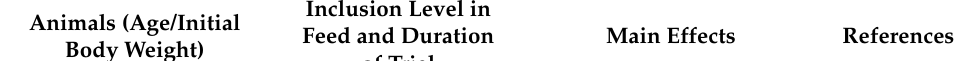
Table 5. Summary of the main effects of inclusion of Chlorella vulgaris (CV) biomass in swine